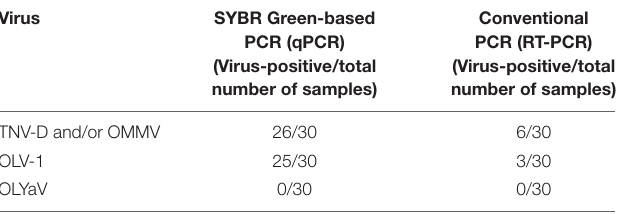
TABLE 4 | Comparison of SYBR R (cid:13) Green-based real-time quantitative reverse transcription PCR assays with conventional PCR, for virus detection in field-collected samples from a Portuguese olive orchard, with cv. “Galega vulgar.”